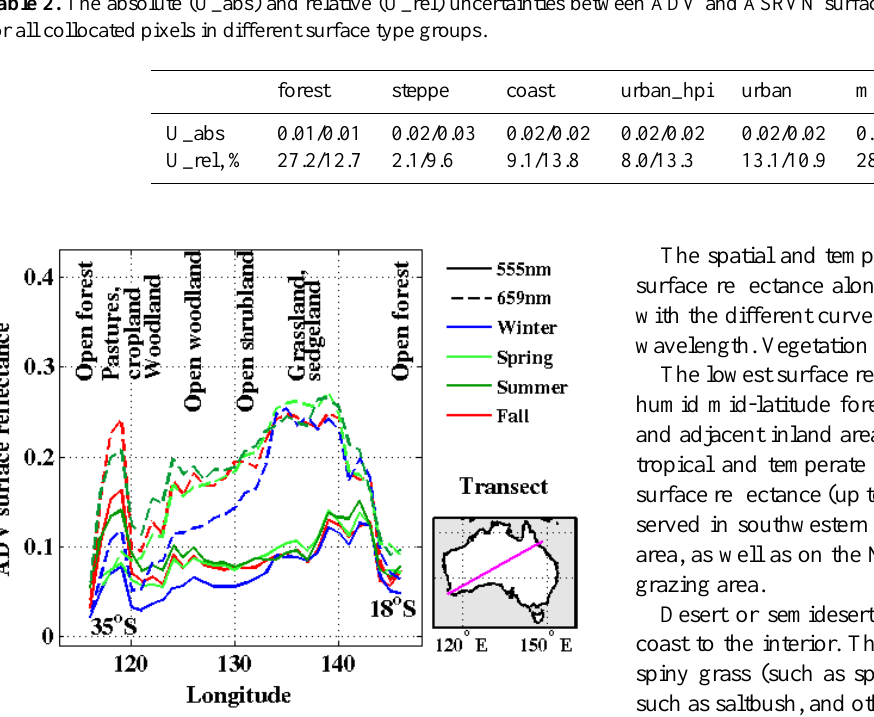
Figure 14. ADV surface reflectance for 555nm (solid lines) and for 659nm (dashed lines) for winter (June, blue line), spring (September, light-green line), summer (January, green line) and fall (March, red line) along the transect (35 ◦ S, 115 ◦ E–18 ◦ S, 148 ◦ E) over Australia (bottom right image). Vegetation types (http://www. environment.gov.au/node/21580), related to certain areas along the transect, are shown at the top of the